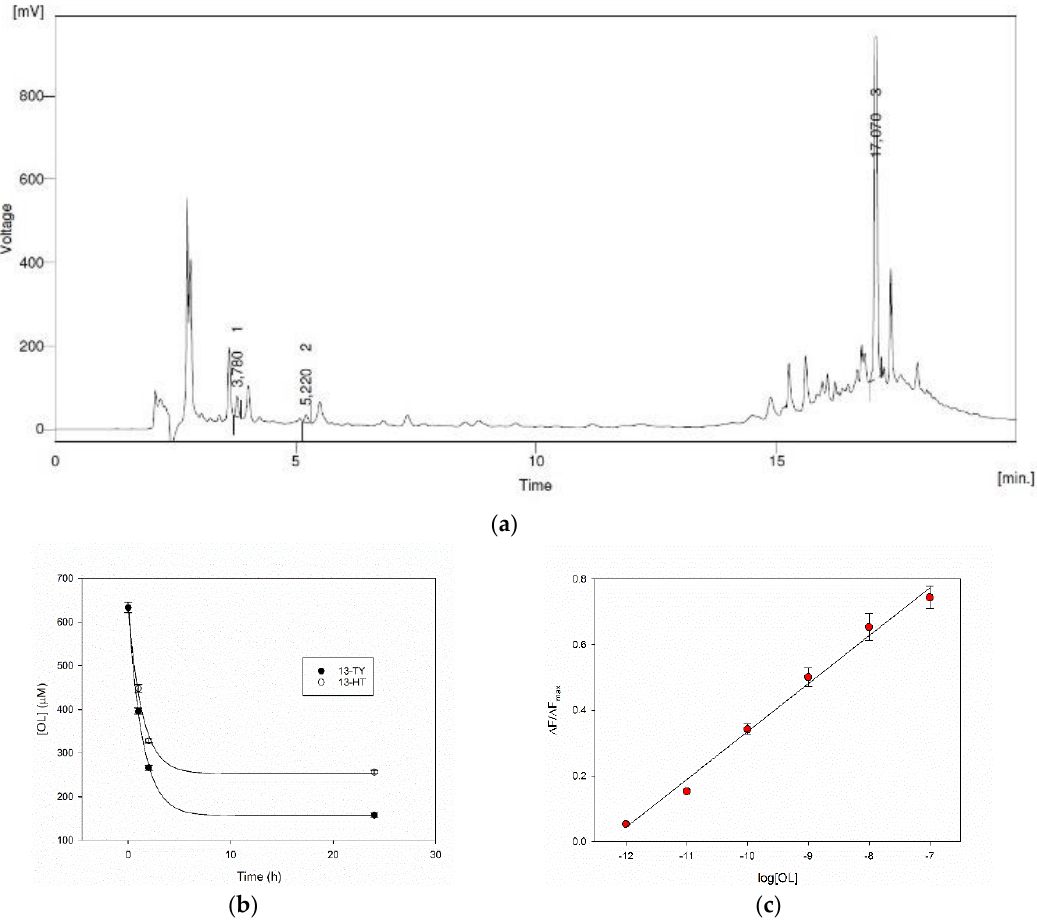
Figure 7. ( a ) HPLC analysis of olive leaves extracts, ( b ) capture of OL from olive leaf extracts after addition of MIPs, ( c ) calibration curve of fluorescence enhancement after addition of OL to MIP 13-TY (r 2 = 0.991, intercept 1.796 ± 0.067, slope 0.1461 ± 0.0069).